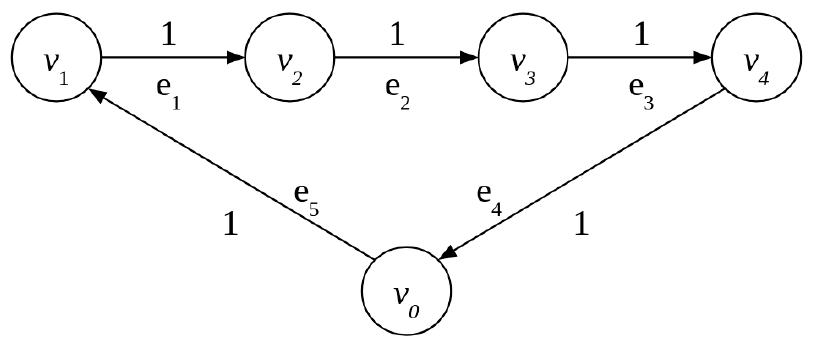
Figure 4. A payment system with a chain of